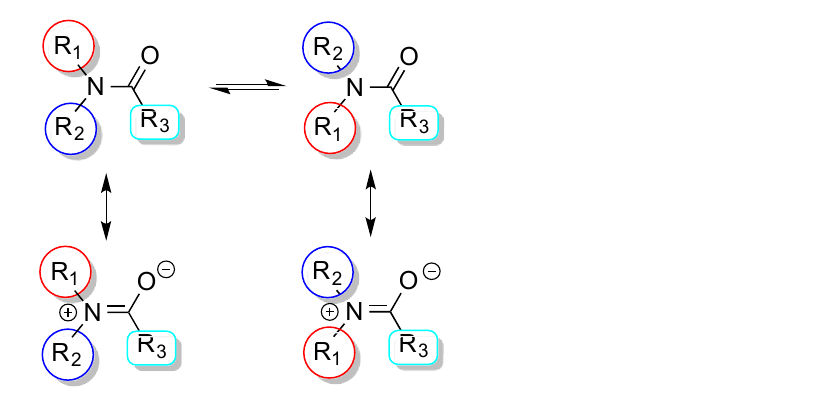
Scheme 1. The general scheme of amide bond inversion.